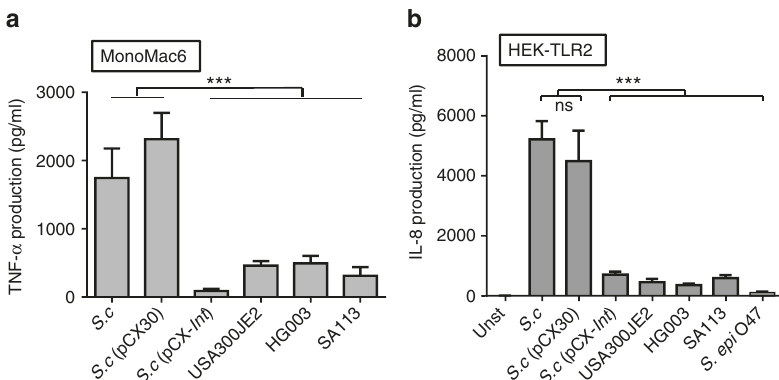
Fig. 1 Induction of cytokines by MonoMac6 and HEK-TLR2 cells infected by different staphylococci strains. ( a ) TNF- α production (pg/ml) after 4-h stimulation of MonoMac6 cells with different staphylococcal strains (MOI 30). ( b ) IL-8 production (pg/ml) after 18-h stimulation of permanent TLR2- transfected HEK cells with different strains (MOI 10). For the infection, the staphylococcal strains were cultured in TSB plus 0.25% xylose for 15 h and then washed two times with DMEM/F. The experiments in triplicate were conducted at least two times. Error bars indicate standard error (SD). Statistical signi fi cances were calculated by using Student ’ s t tests or analysis of variance (ANOVA): not signi fi cant P > 0.05, * P < 0.05, ** P < 0.01, *** P < 0.001. S.c , S. carnosus ; S.c (pCX30) plasmid without insert; S.c (pCX- lnt ) plasmid encoding E. coli -speci fi c lnt gene; USA300JE2, HG003, and SA113 represent different S. aureus strains, and S. epidermidis